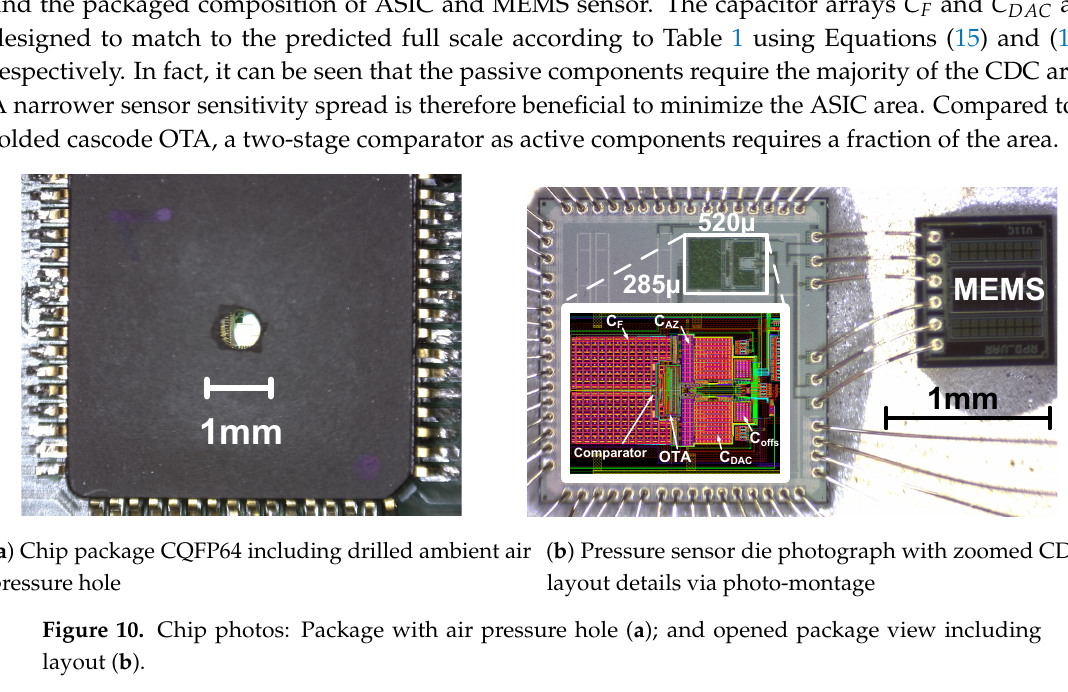
Figure 10. Chip photos: Package with air pressure hole ( a ); and opened package view including layout ( b ).